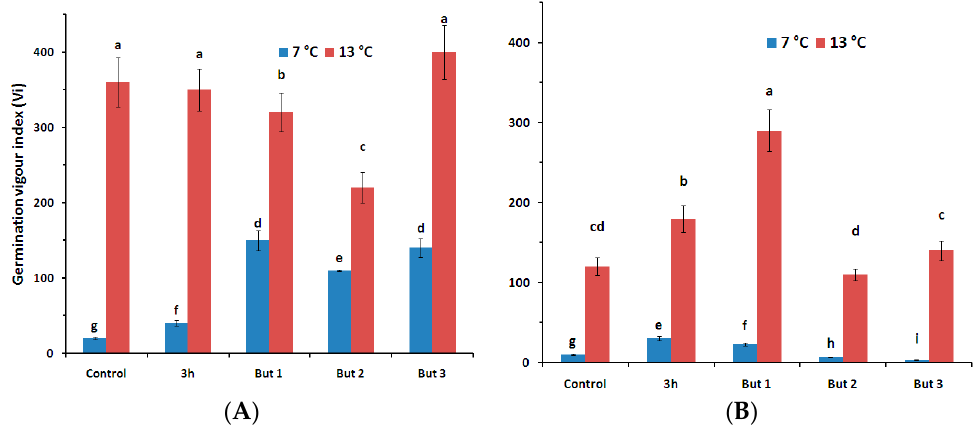
Figure 1. Germination vigour index (Vi) of seeds of L. angustifolius cultivars (Lazur—( A ) and Sethes Fruehe Rote—( B )) germinated at 7 °C or 13 °C in water (control), butenolide or hydroprimed in water for 3 h at 20 °C. But 1, But 2, But 3: 10 − 6 M, 10 − 5 M, 10 − 4 M butenolide, respectively. Values represent means ( n = 5) ± SE. Different letters over error bars (a, b, c, …) indicate significant differences (Duncan’s multiple range test, p < 0.05).